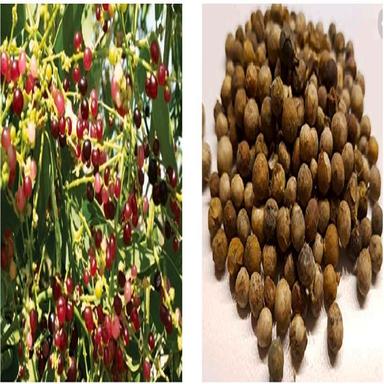
Field Photographs of Peelu Crop Fruits & Dry Seeds.